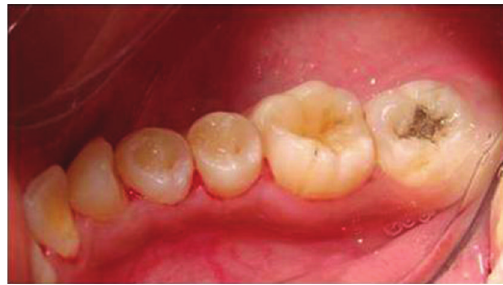
Figure 22: Lingual view of 46, seven days after reattachment and after suture removal.